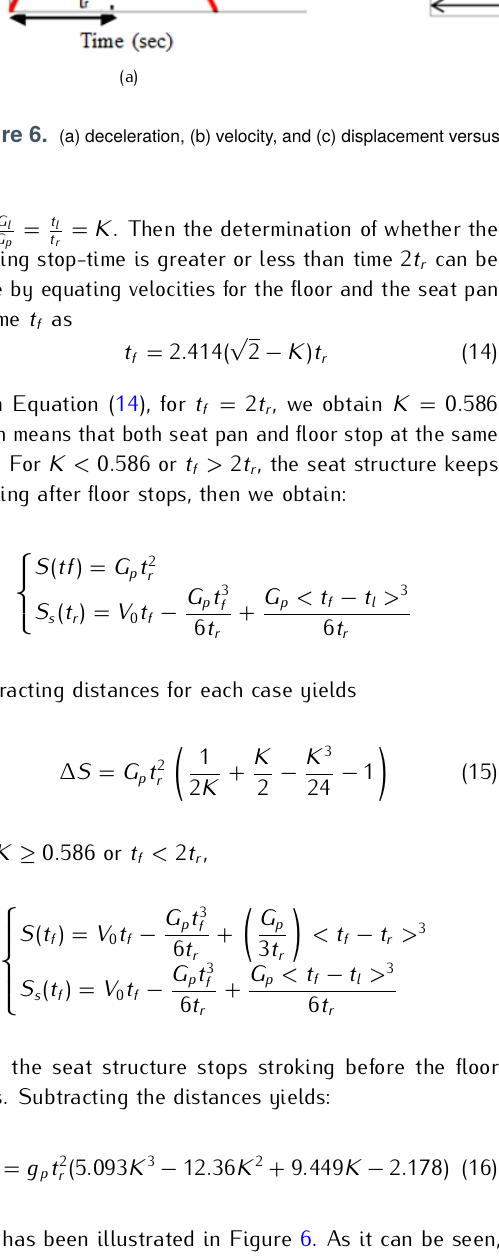
0 . 586 and K > 0 . 586